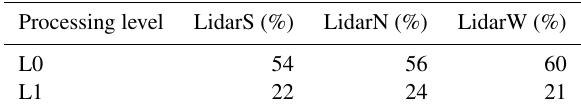
Table 2. Scanning lidar data availability from 1 February 2019